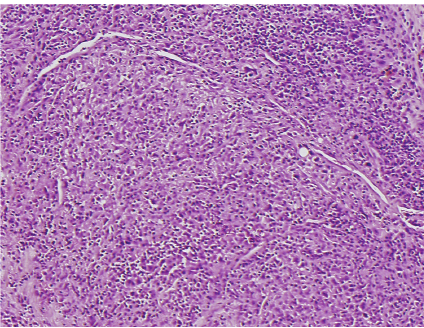
Figure 5: Tumour cell arranged along curvilinear blood vessels (H&E × 100).